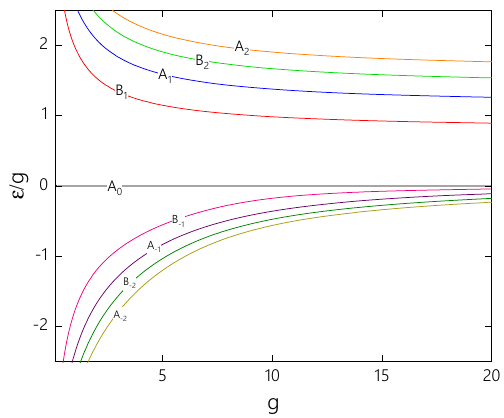
Fig. 2 Normalized energy of the localized fermionic states as a func- tion of the Yukawa coupling g for first nine modes at m = 0 with backreaction